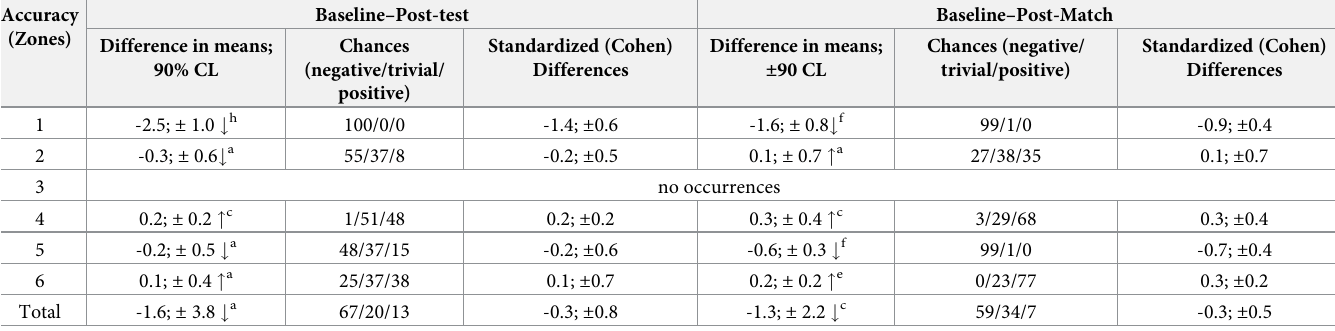
Table 3. Descriptive statistics for the comparison between the traditional and differential learning interventions on the accuracy